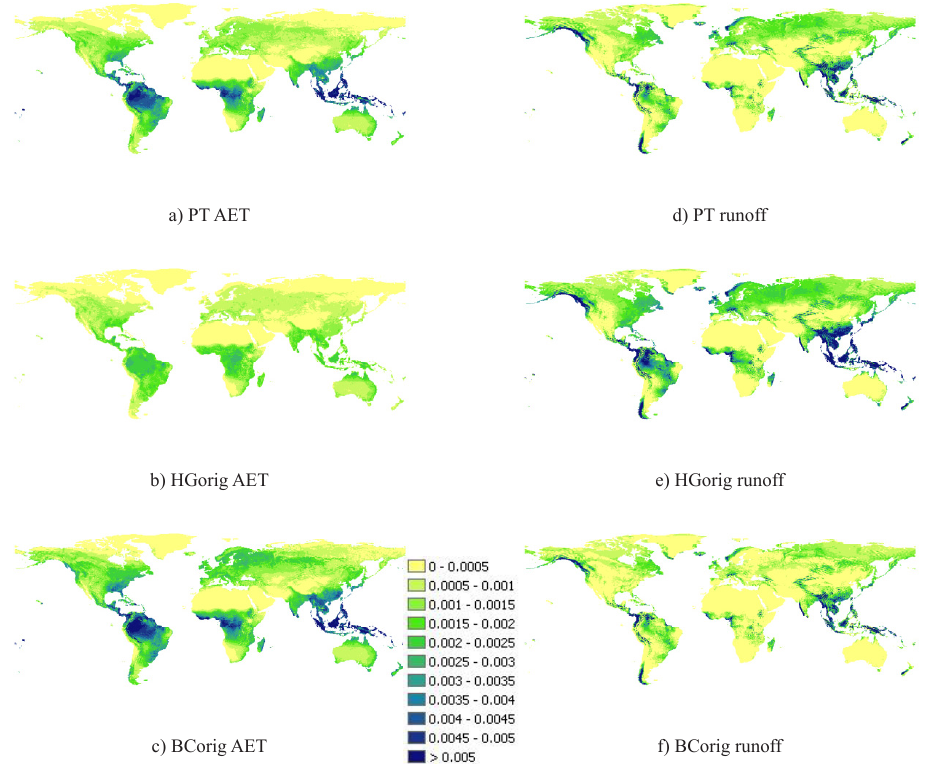
Fig. 7b. Global maps with on the left annual average daily actual evapotranspiration (mday − 1 ) and on the right annual average daily runoff (mday − 1 ) . From top to bottom, Priestley-Taylor (PT), the original Hargreaves equation (HGorig) and the original Blaney-Criddle equation (BCorig).